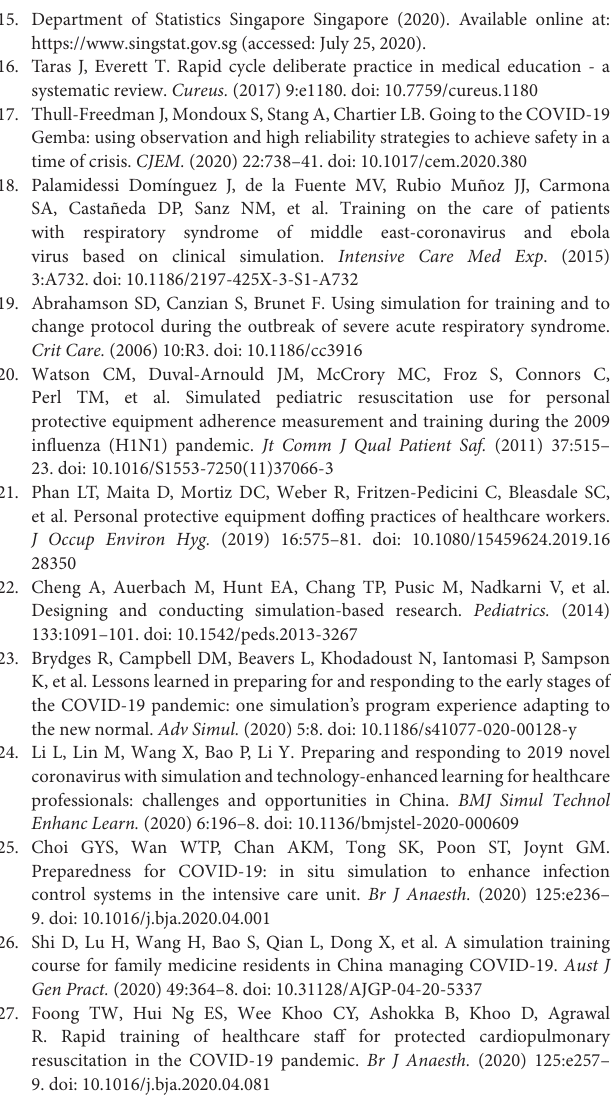
(Level 2 training). Supplementary Figure 2 | Transporting newborn infant delivered to mother with suspected COVID-19 from operating theater to isolation neonatal ICU after emergency Cesarean section (Level 3